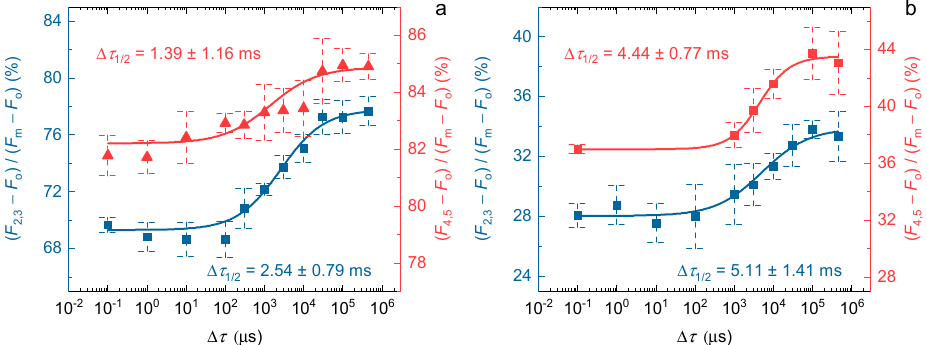
Figure 5. Dependence of the F 2 -to- F 3 (blue) and the F 4 -to- F 5 (red) Chl- a fluorescence levels on the ∆ τ time intervals between the second and third, and between the fourth and fifth STSFs, respectively, in DCMU-treated T. vulcanus PSII CC at 5 °C ( a ) and at − 80 °C ( b ). Continuous lines represent logistic-function fits of the data points, which represent mean values ± SD ( n = 3–4); the calculated ∆ τ 1/2 values are also indicated. The measurements were performed on the MC-PAM based setup.